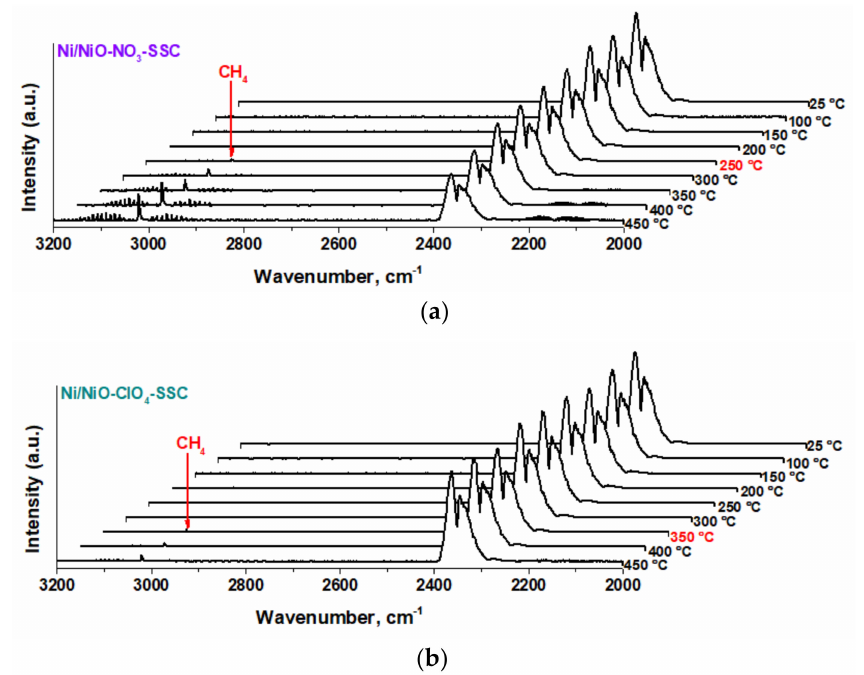
Figure 9. FTIR spectra of gases at the outlet of the reactor during the activation of ( a ) Ni/NiO- NO 3 -SSC and ( b ) Ni/NiO-ClO 4 -SSC at different temperatures in the reaction medium. Activation conditions: volume ratio is H 2 :CO 2 :Ar = 16:4:80, hourly mass feed flow rate is 19,000 cm 3 · g cat − 1 · h − 1